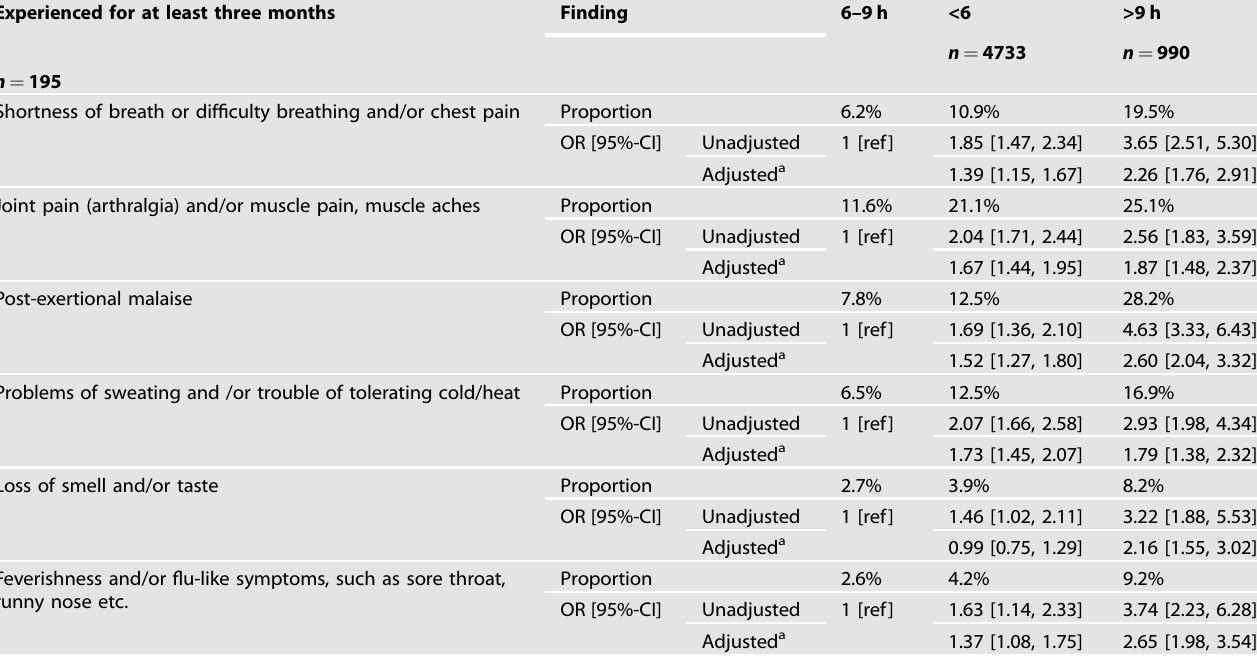
Table 3. Association of habitual nighttime sleep duration with individual post-COVID symtpoms among those receiving two mRNA vaccinations. Experienced for at least three months n =